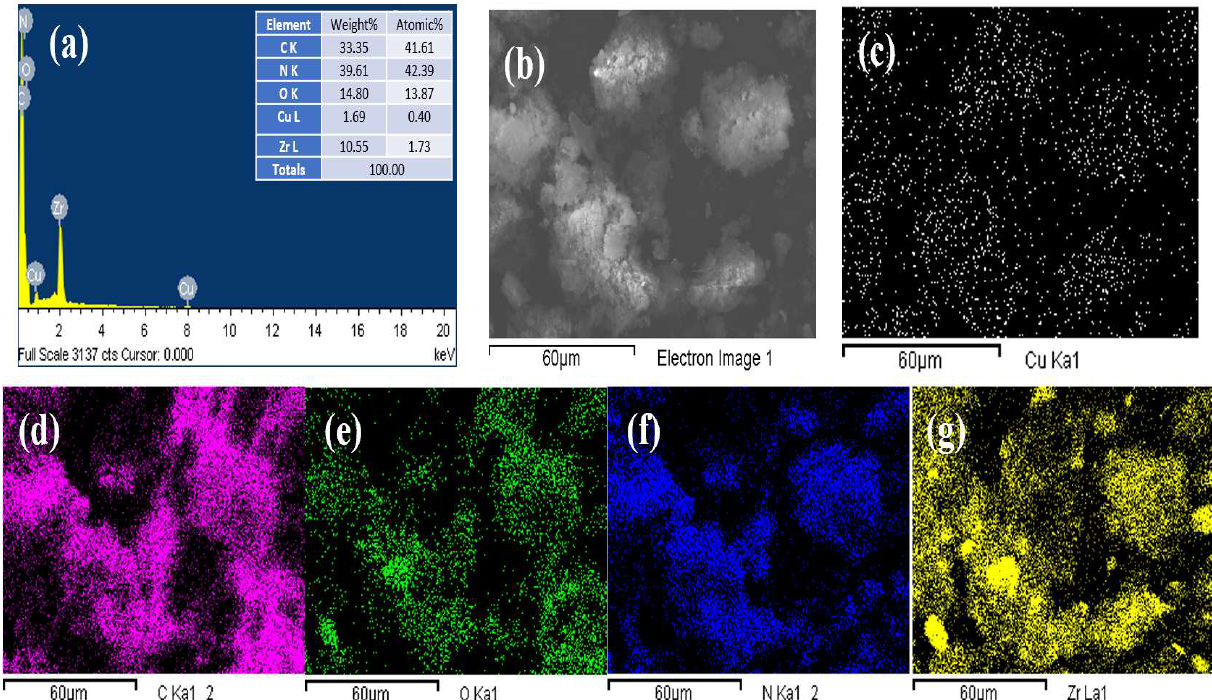
Figure 7. ( a ) EDX spectrum for elements composition; ( b ) SEM image; ( c – g ) elemental mapping of C, N, O, and Zr after Cu 2+ adsorption onto Zr-G-C 3 N 4 nanocomposite.